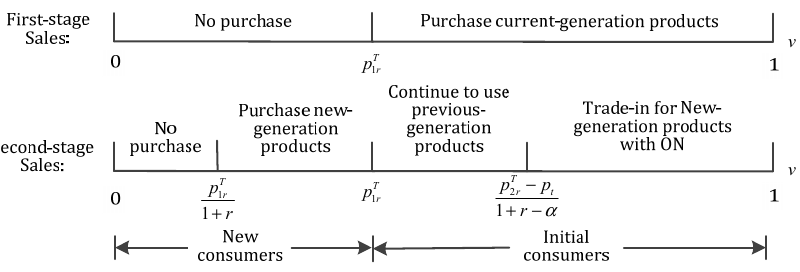
Figure 3. Consumers’ purchasing decisions in ON model.